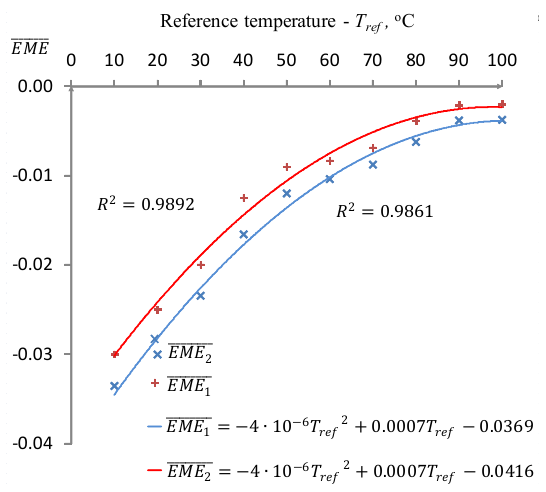
Fig. 8. Mean values of the relative experimental error (cid:1831)(cid:1839)(cid:1831) (cid:3364)(cid:3364)(cid:3364)(cid:3364)(cid:3364)(cid:3364)(cid:3364) as a function of the reference temperature T ref .